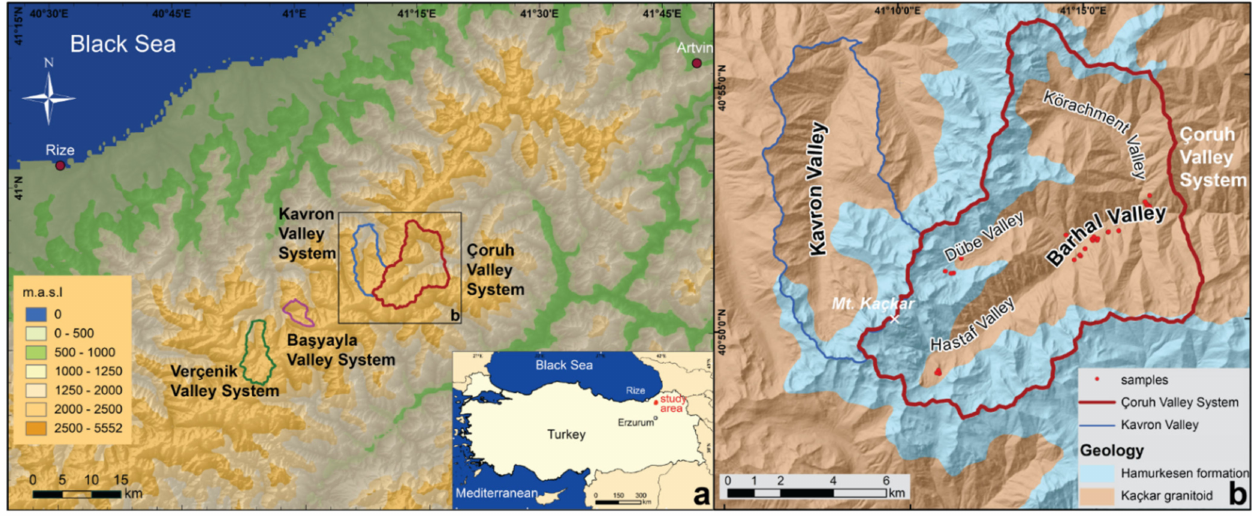
Figure 1. ( a ) Index map for the Çoruh Valley System in the Kaçkar Mountains of NE Anatolia: Kavron Valley System [10], Verçenik Valley System [11], Ba¸syayla Valley System [12], Çoruh Valley system (this paper). ( b ) Neighboring Kavron and Barhal Valley descending from the highest peak of Mt. Kaçkar 3932 m. Çoruh Valley System with Hastaf, Dübe, and Körahmet tributaries, and Barhal Valley, referred to as the main valley (sample clusters red